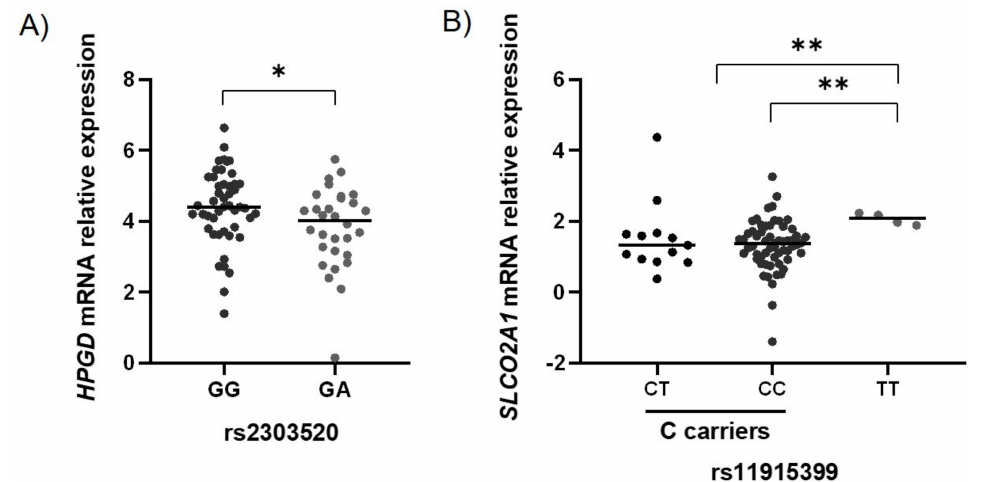
Figure 1. ( A ) Hydroxyprostaglandin dehydrogenase 15-(NAD) ( HPGD ) mRNA relative expression considering the genotypes of the rs2303520 G>A polymorphism. In “normal”-appearing mucosa, the GA genotype is associated with HPGD mRNA downregulation by a mean factor of 0.67. Lines represent median values of expression. ( B ) Solute carrier organic anion transporter family member 2A1 ( SLCO2A1 ) mRNA relative expression considering the genotypes of the rs11915399 C > T polymorphism. In “normal”-appearing mucosa, the TT genotype is associated with SLCO2A1 mRNA upregulation compared to the CC genotype and the carriers of the C allele by a mean factor of 1.63 and 1.67, respectively. Lines represent median values of expression. * p < 0.05; ** p <